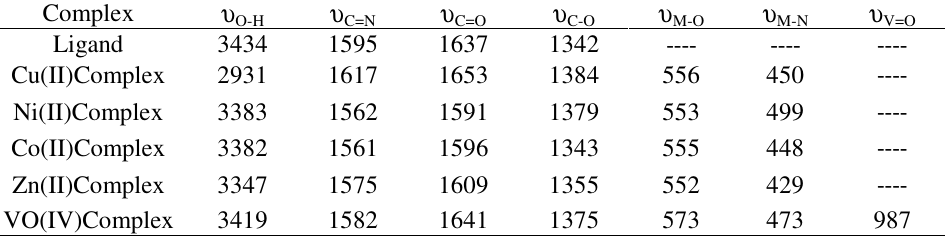
Table 2. IR spectral data of ligand and its complexes in cm